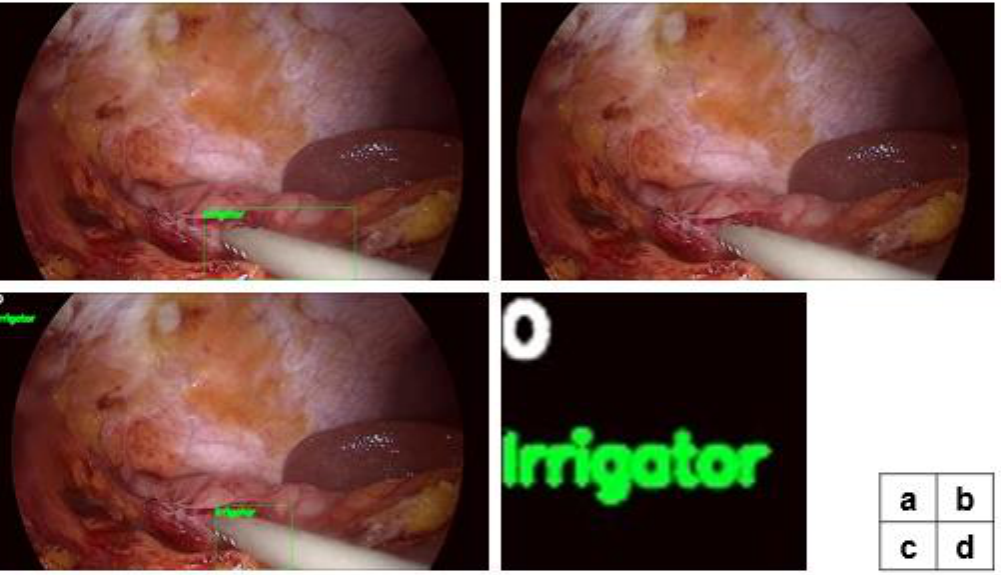
Figure 5. Results of the proposed method. ( a ) The result in the previous frame (t-1). ( b ) As a result of applying only YOLO9000 to the current frame (t), it is found that a missing tool exists. ( c ) YOLO9000 and the missing tool detection algorithm are executed in the current frame (t), and as a result, the missing surgical tool is detected. ( d ) An enlarged view of the upper left corner of image (c) (the symbol O in white indicates that the tool is missing, and the class name shown below indicates the class of the tool detected through missing tool detection).